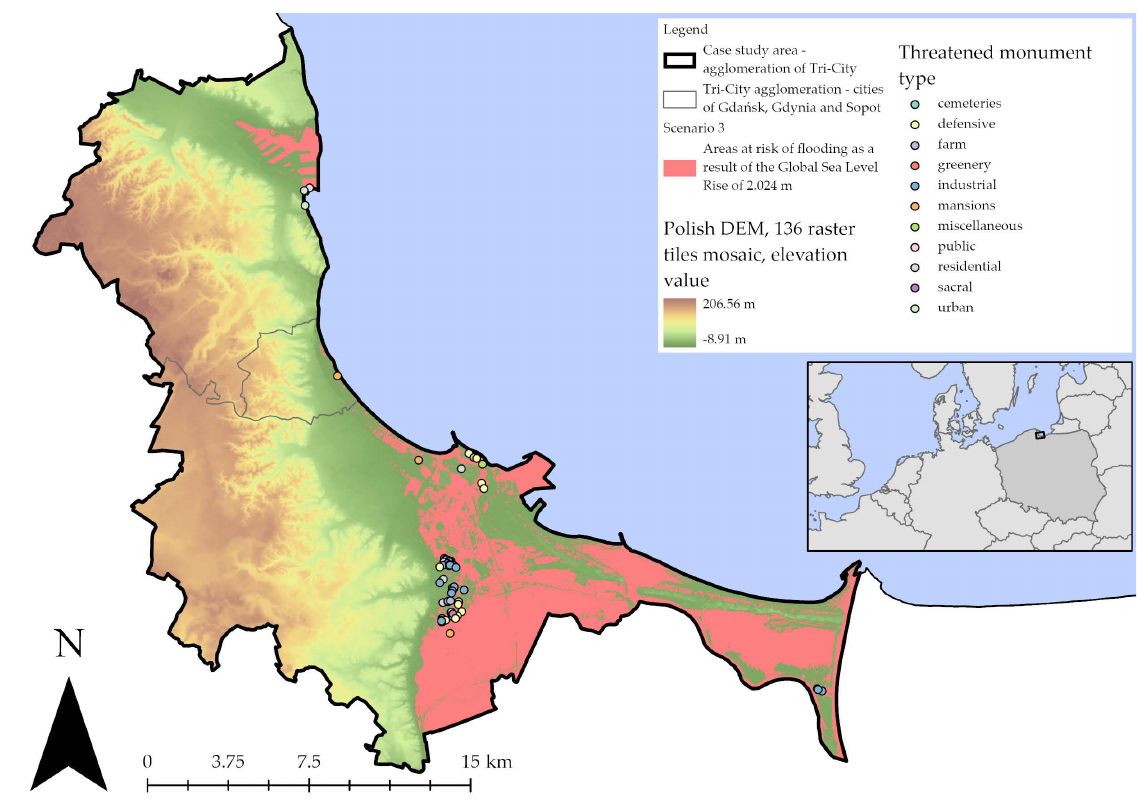
Figure 11. Global sea level rise scenario 3 for the case study area (the year 2100). Source: own elaboration using ArcGIS Pro 2.7, on the basis of the data from Polish